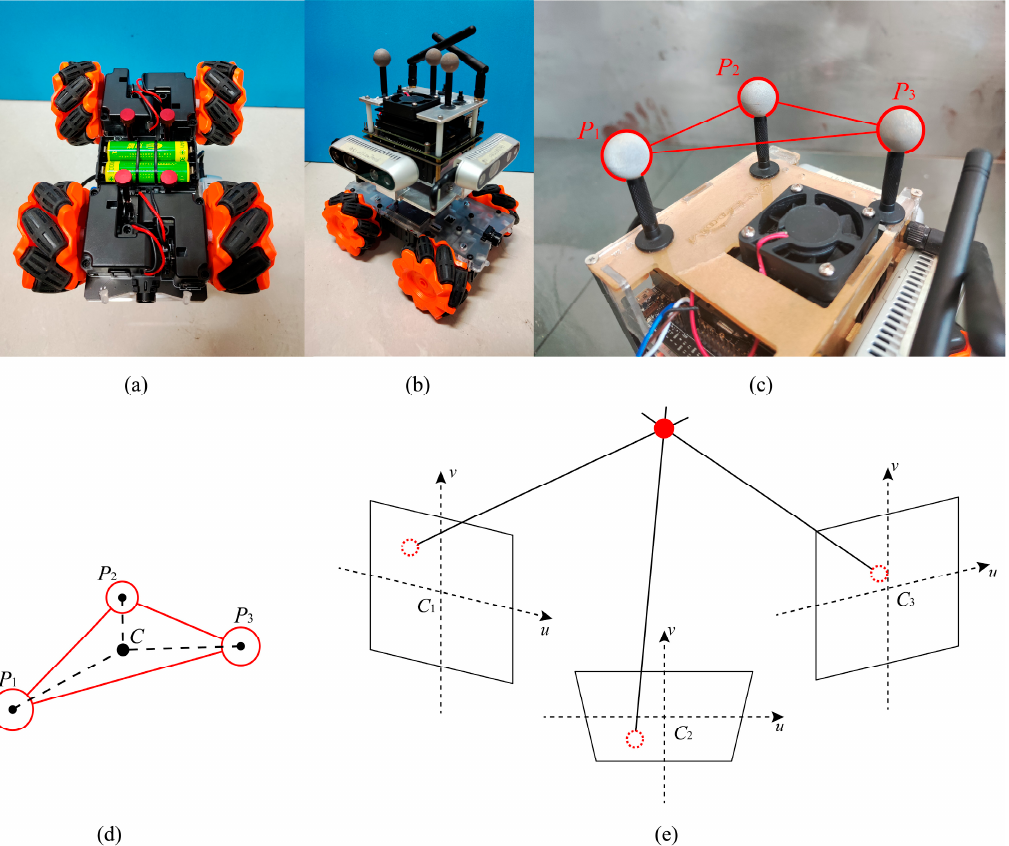
Figure 8. Prototype of mobile robot and the motion capture system. ( a ) The four Mecanum wheels of the mobile robot. ( b ) The overall view of the mobile robot prototype. ( c ) Marked points on the mobile robot. ( d ) The rigid triangle formed by marked points that represents the motion of the mobile robot. ( e ) The geometric principle of the multiple-camera stereo system.